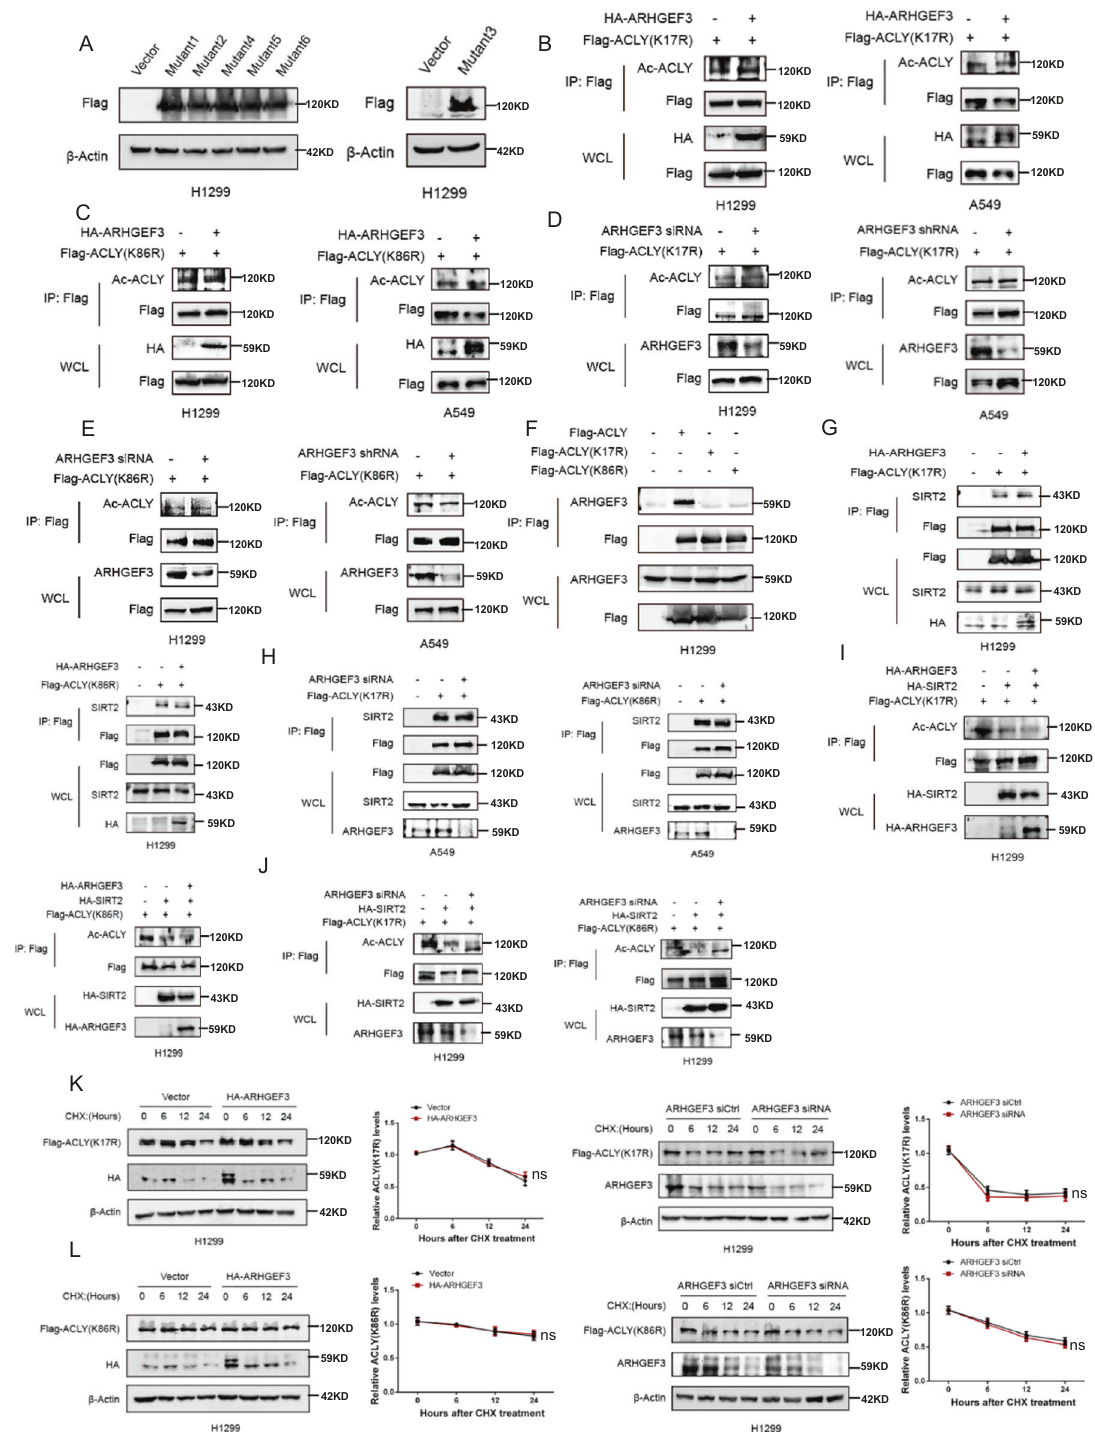
Fig. 4 The K17 and K86 were essential acetylation sites of ACLY for ARHGEF3 to recruit SIRT2 for deacetylating and stabilizing ACLY. A Six ACLY acetylation-de fi cient mutants. B , C H1299 and A549 cells were co-transfected with pcDNA3.1-HA-ARHGEF3, and ACLY mutants, the acetylation of ACLY-K17R and K86R was checked by immunoprecipitation and western blot. D , E H1299 and A549 cells were co-transfected with ARHGEF3 siRNA or shRNA and ACLY mutants, the acetylation of ACLY-K17R and 86 R was checked by immunoprecipitation and western blot. F The interaction between ARHGEF3 and ACLY, ACLY-K17R, 86 R. G The effect of ARHGEF3 overexpression on SIRT2-ACLY(K17R)/(K86R) interaction was detected by western blot. H The effect of ARHGEF3 knockdown on SIRT2-ACLY (K17R)/(K86R) interaction was detected by western blot. I H1299 cells were transfected with Flag-tagged SIRT2 and Flag-tagged ACLY-K17R or 86 R and HA-tagged ARHGEF3. The acetylation of ACLY-K17R and 86R were determined by western blot. J Flag-tagged SIRT2, Flag-tagged ACLY-K17R or 86R and ARHGEF3 siRNA were co-transfected in H1299 cells. Western blot was used to check the acetylation of ACLY-K17R and 86R. K , L Cycloheximide (CHX) (25 μ g/ml) was incubated for the indicated period with H1299 cells transfected with ACLY mutants and pcDNA3.1-HA-ARHGEF3 or ARHGEF3 siRNA. Western blot was used to detect the effects of ARHGEF3 on the degradation rates of ACLY-K17R and 86 R (left). Degradation curve ACLY-K17R and 86 R (right). The results represent the average of three independently repeated experiments (mean ± SD), ns no signi fi cance. Cell Death and Disease (2022)